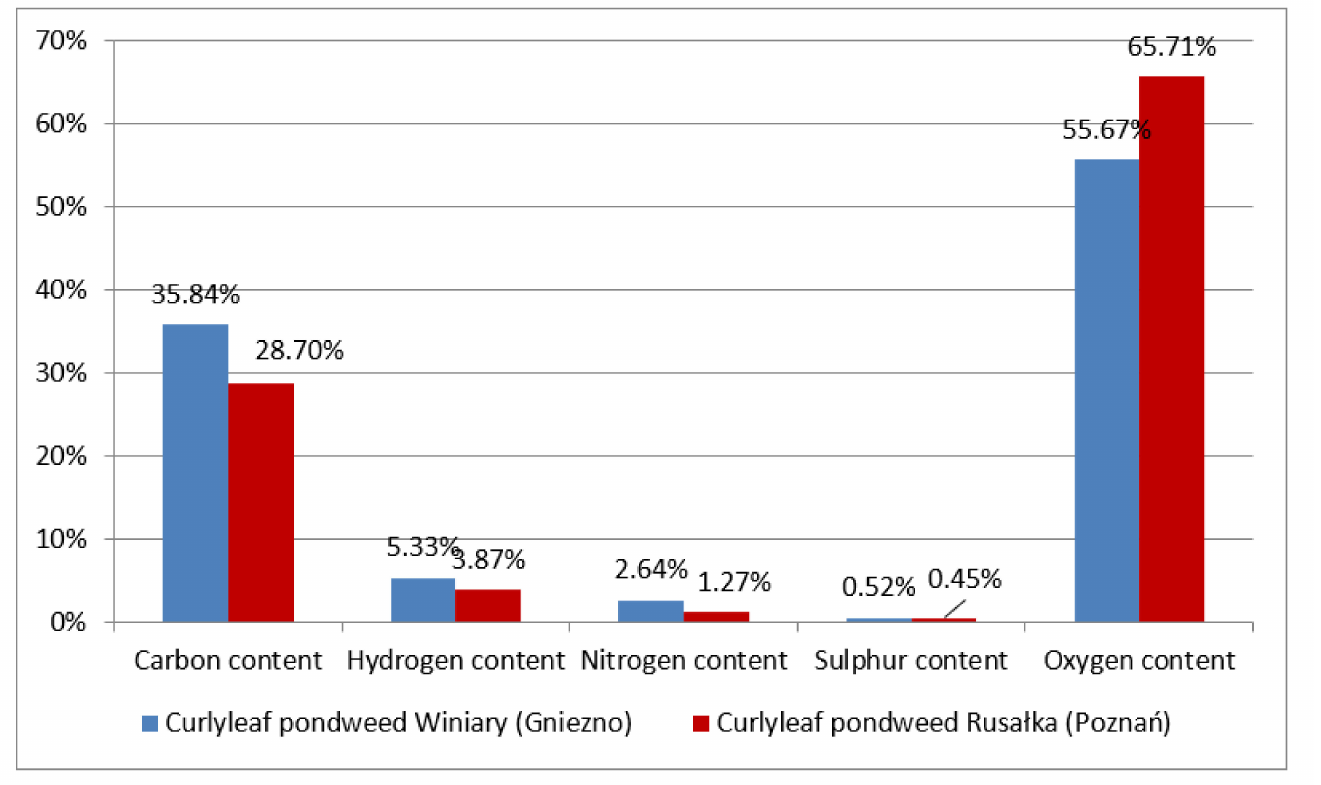
Figure 3. Elemental analysis results for the curly-leaf pondweed samples